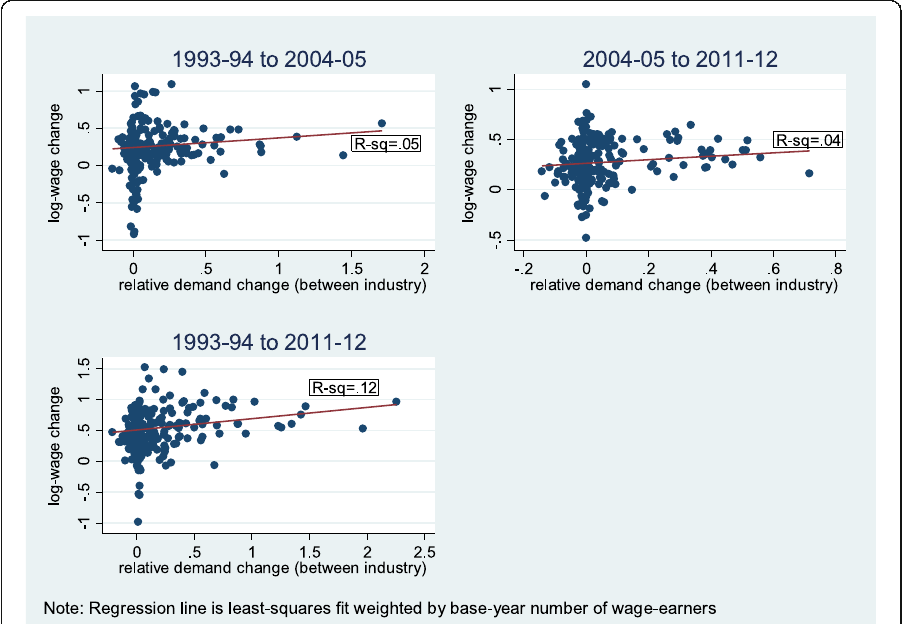
Fig. 8 Bivariate relationship between state/group wage changes and demand